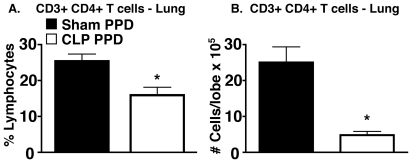
Percentage and total number of CD3+ CD4+ T cells in lungs of PPD-challenged mice.Lobes from sham and CLP RAG PPD-challenged mice were processed into a single-cell suspension and analyzed via flow cytometry for the presence of CD3+ CD4+ T cells. (A) Percentages of CD3+ CD4+ T cells were obtained by gating on the standard forward/side scatter profile of lymphocytes . (B) Total numbers of CD3+ CD4+ T cells were obtained by multiplying the percentages obtained via flow cytometry via the total viable cell count (hemacytometer & vital dye exclusion). Data presented is representative of two separate experiments, n = 5 per group. (*) = p<0.05 vs. sham RAG.